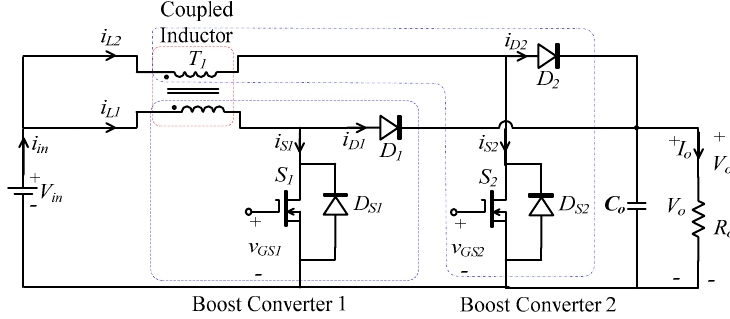
Figure 1. Proposed interleaved dc-to-dc converter.